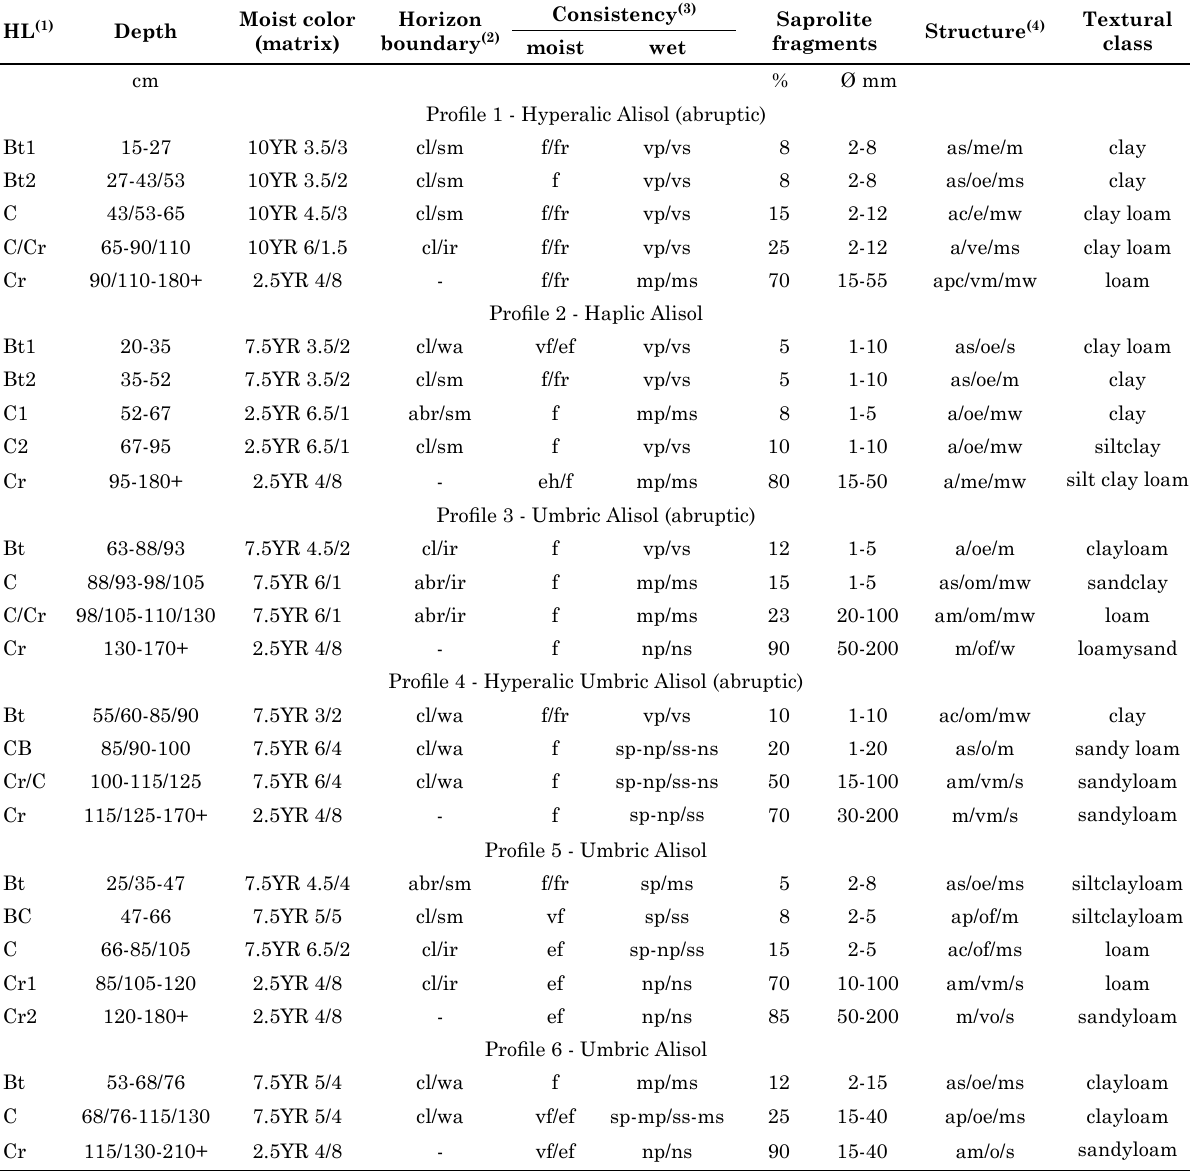
Table 2. Morphological data of the Alisol profiles hL